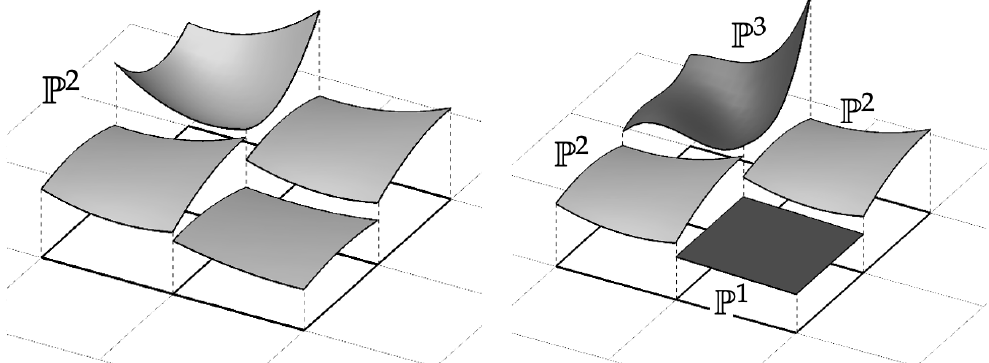
Figure 1. Comparison between a fixed ( left ) and variable ( right ) order approach to represent the